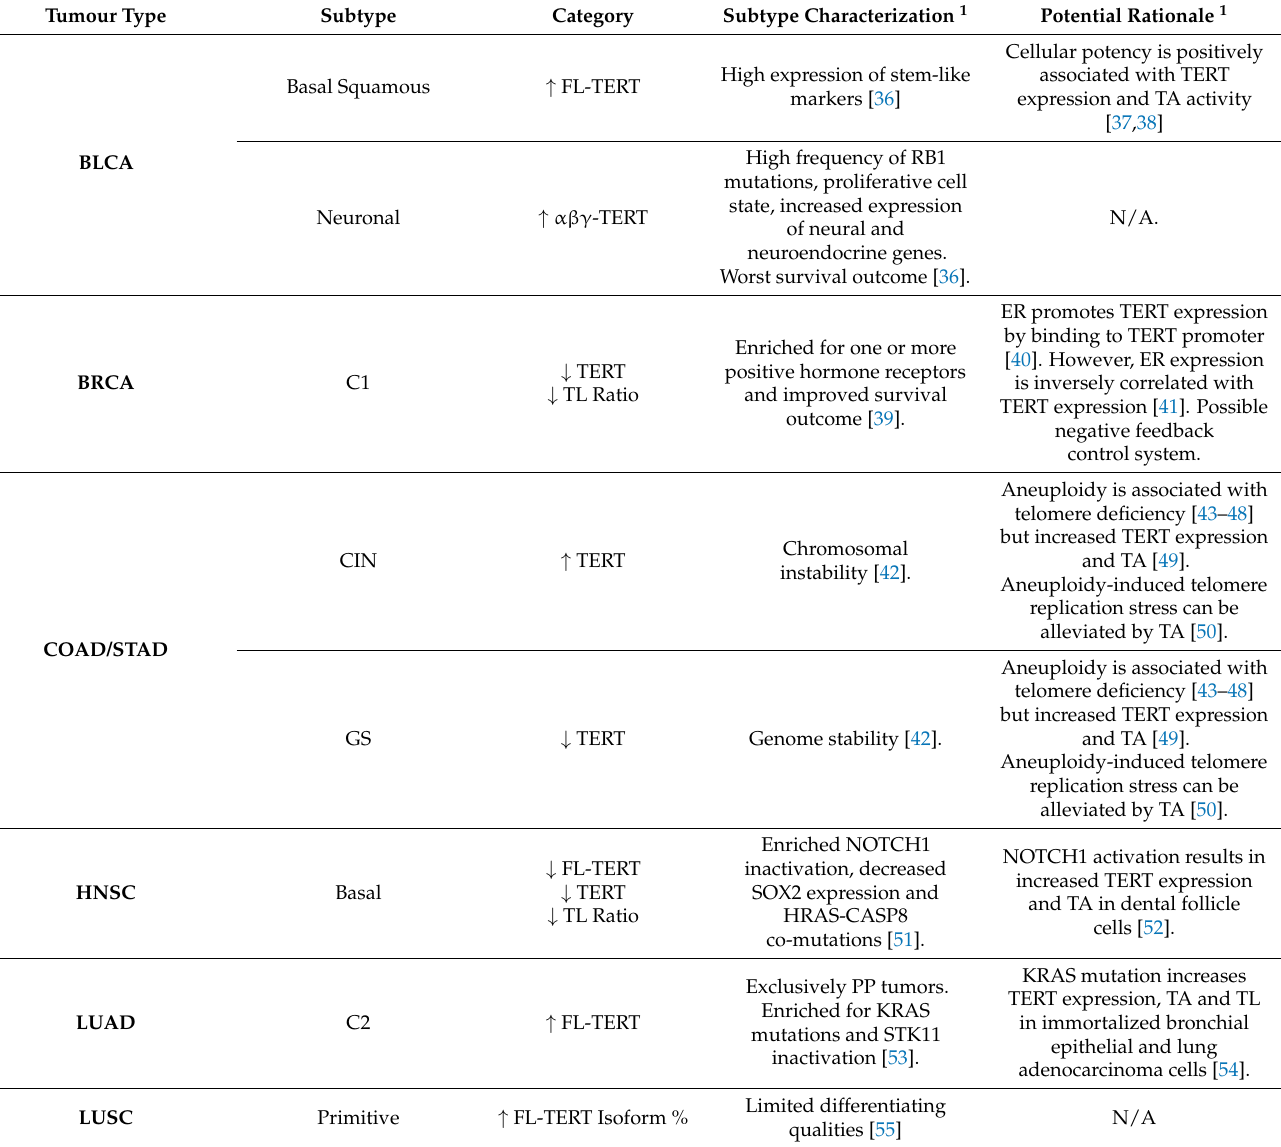
Table 1. Significant tumor-specific subtype-dependent differences in TERT expression or telomere length. Tumour